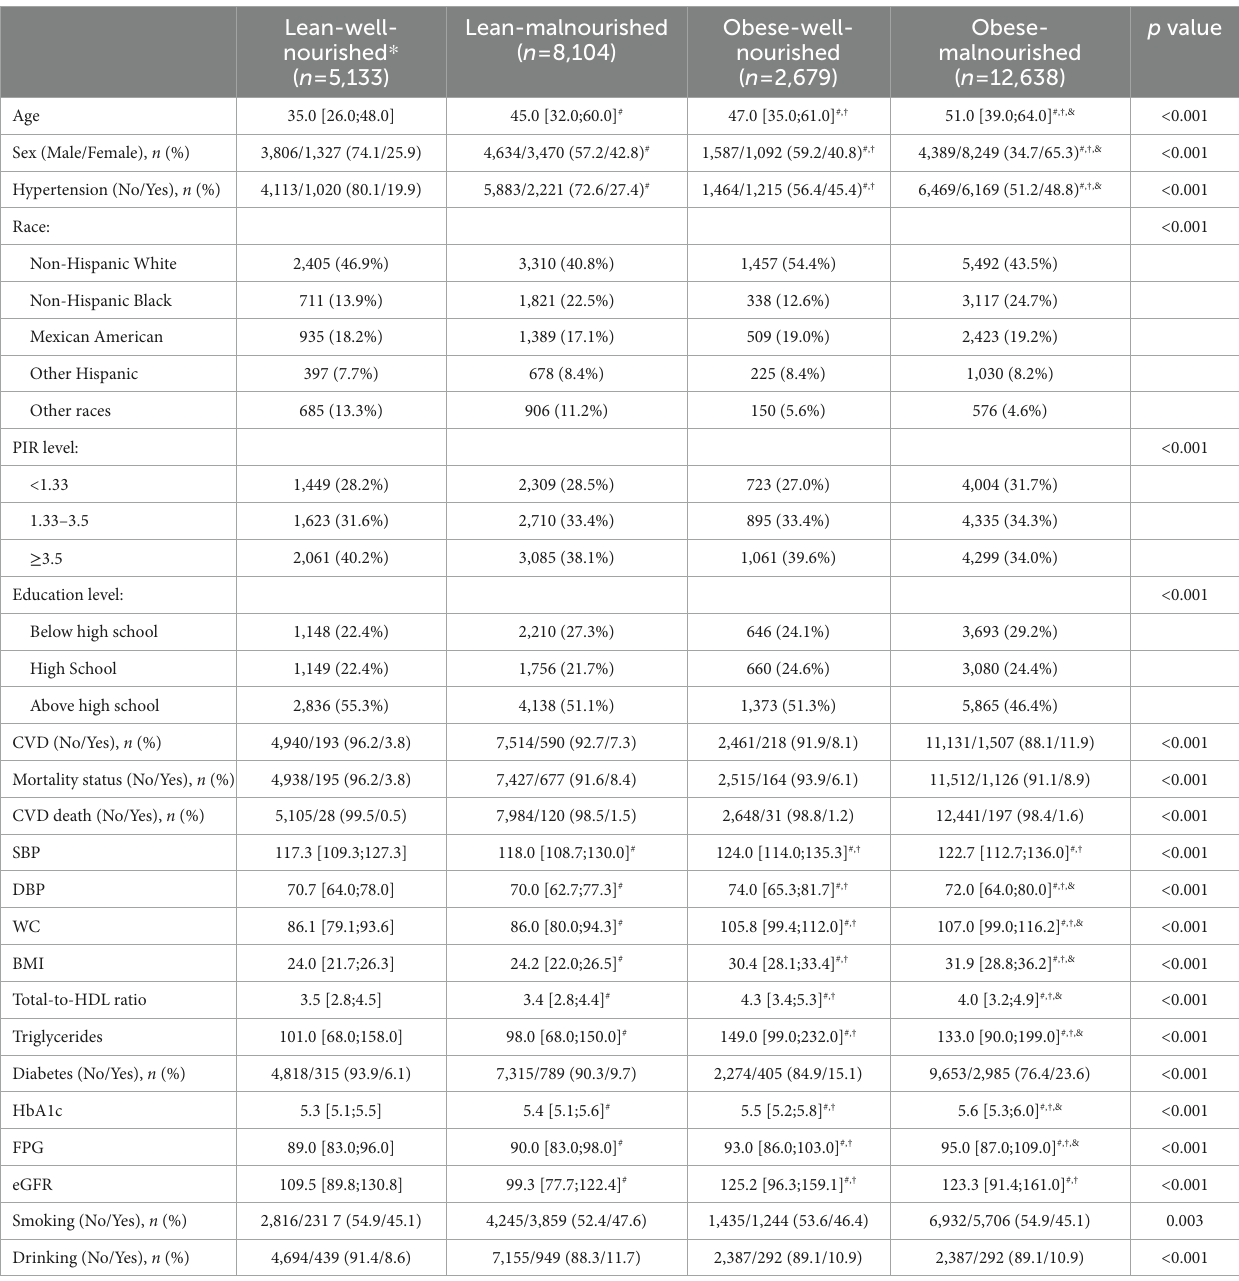
TABLE 1 Baseline characteristics of the study